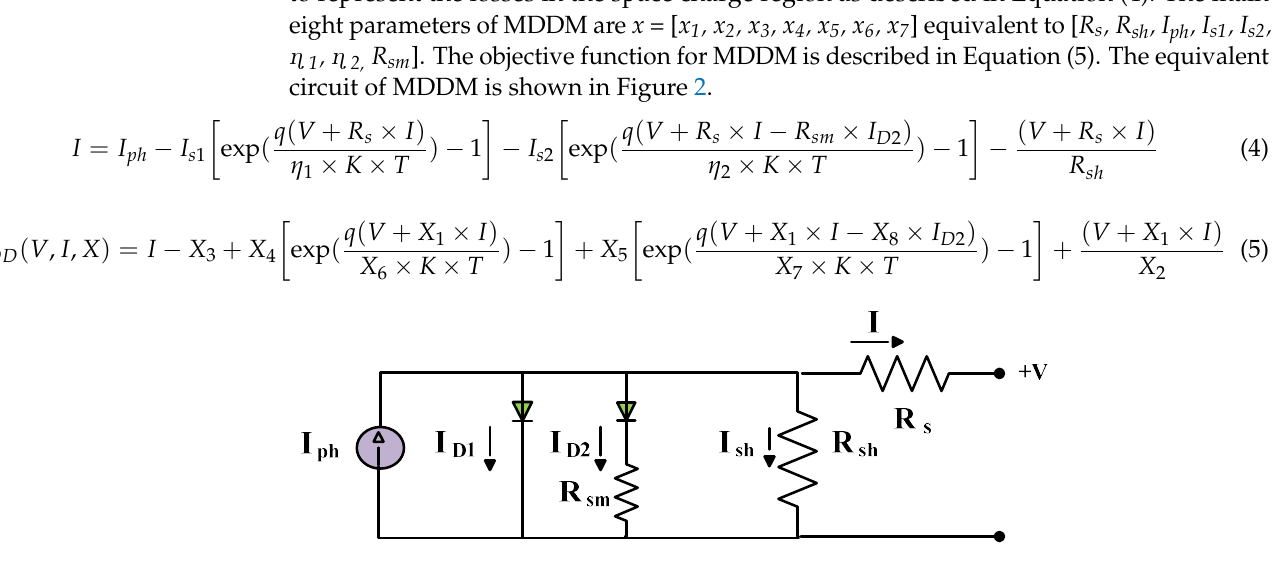
Figure 2. MDDM. Figure 2.